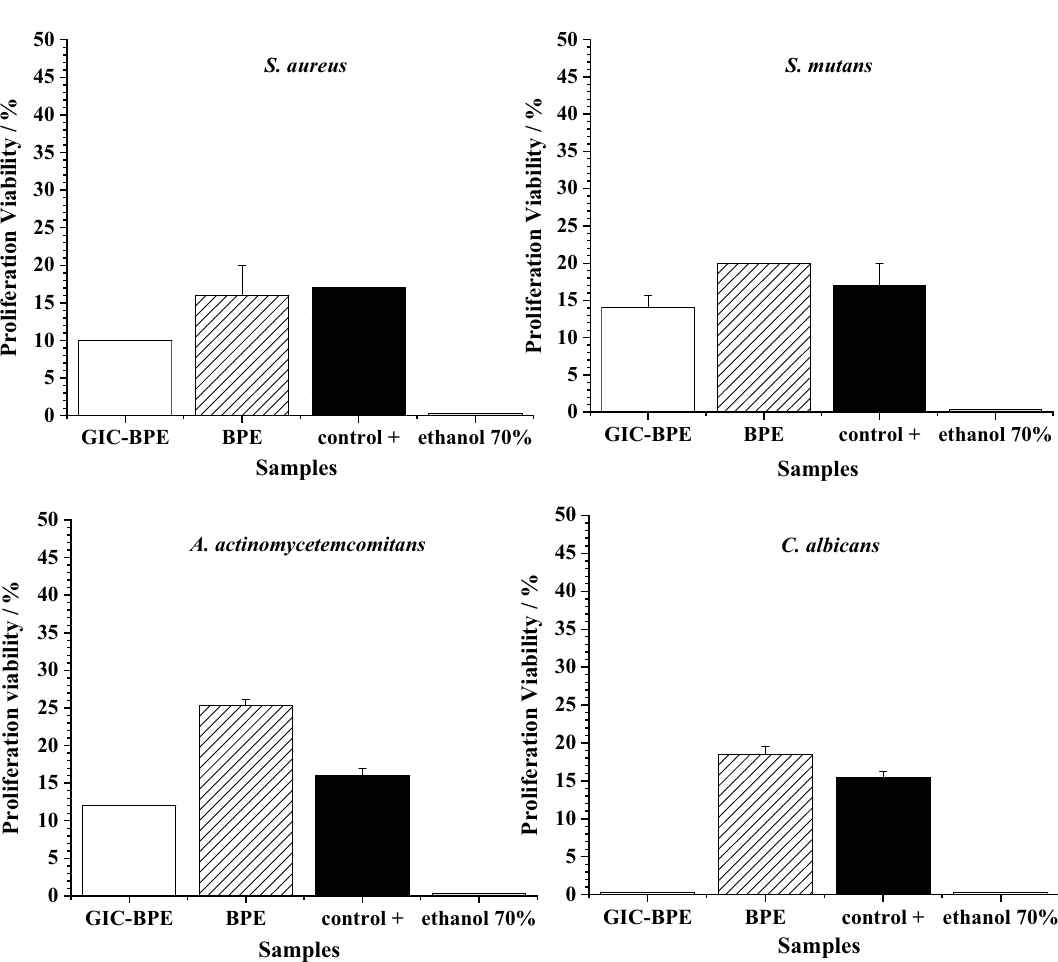
Figure 6. Susceptibility of samples of: a glass-ionomer—Brazilian pepper extract cylindrical pellet (GIC-PE), and blank disks soaked in ethanolic Brazilian pepper extract (BPE), positive control (chlorhexidine or nystatin for bacteria or yeast, respectively), and solvent control (ethanol 70%), against S. aureus , S. mutans , A. actinomycetemcomitans , and C. albicans . Media and standard deviation (MD ± SD), mean of three